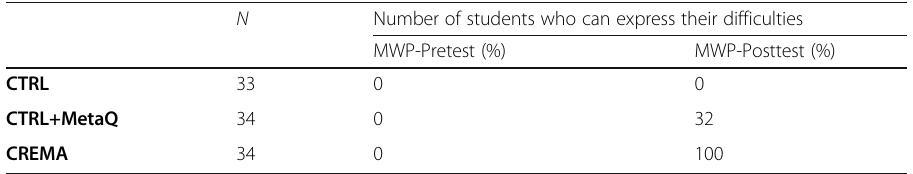
solving MWP in the pretest and posttest of MWP among the three groups